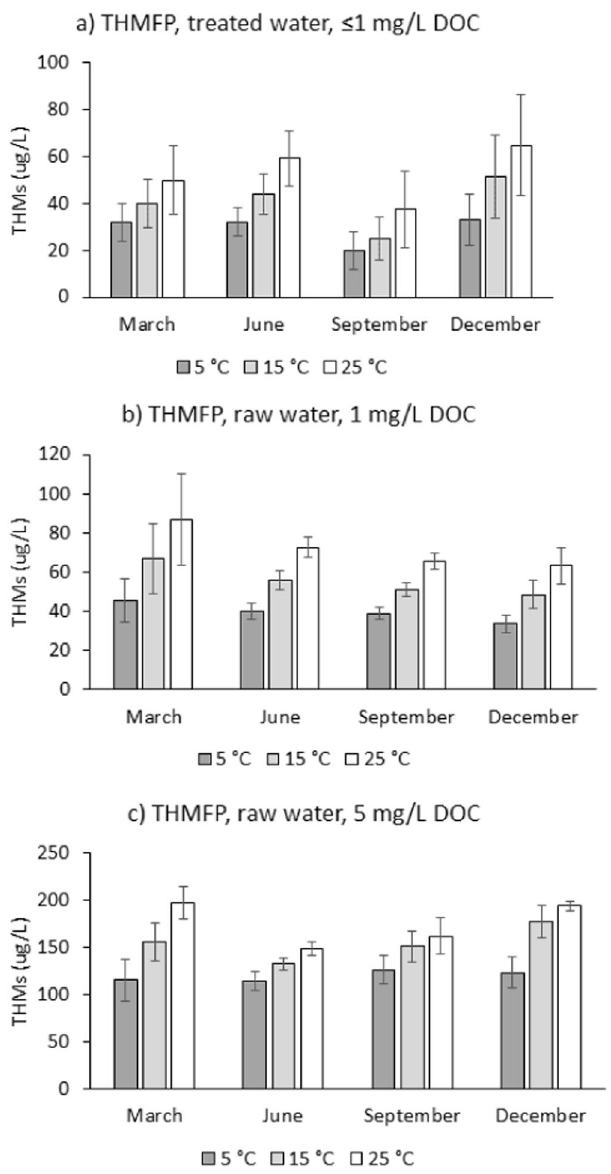
Figure 2. Average trihalomethanes formation potential (THMFP) in ( a ) treated (potable) water sampled from five Scottish water treatment plants before the point of disinfection, and their raw water, diluted to a dissolved organic carbon (DOC) content of ( b ) 1 mg/L and ( c ) 5 mg/L. Error bars indicate the standard errors (n = 5) for the average THMFP of water from the case study sites described in Table S1 in Supporting